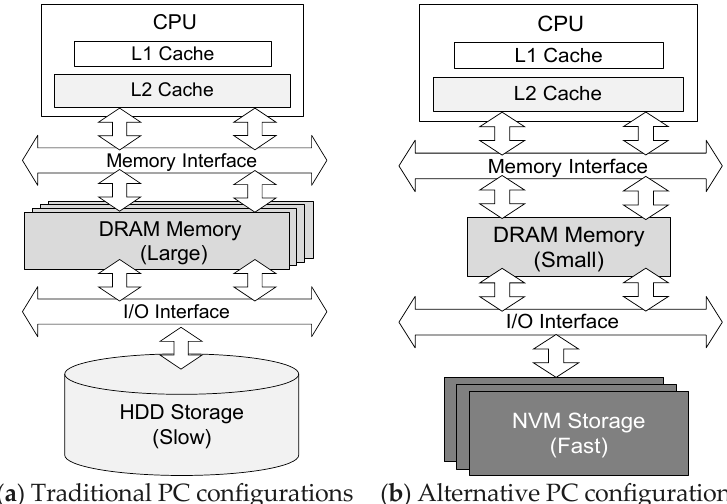
Figure 12. An alternative PC consisting of small DRAM and fast NVM storage in comparison with the traditional PC consisting of large DRAM and slow HDD.